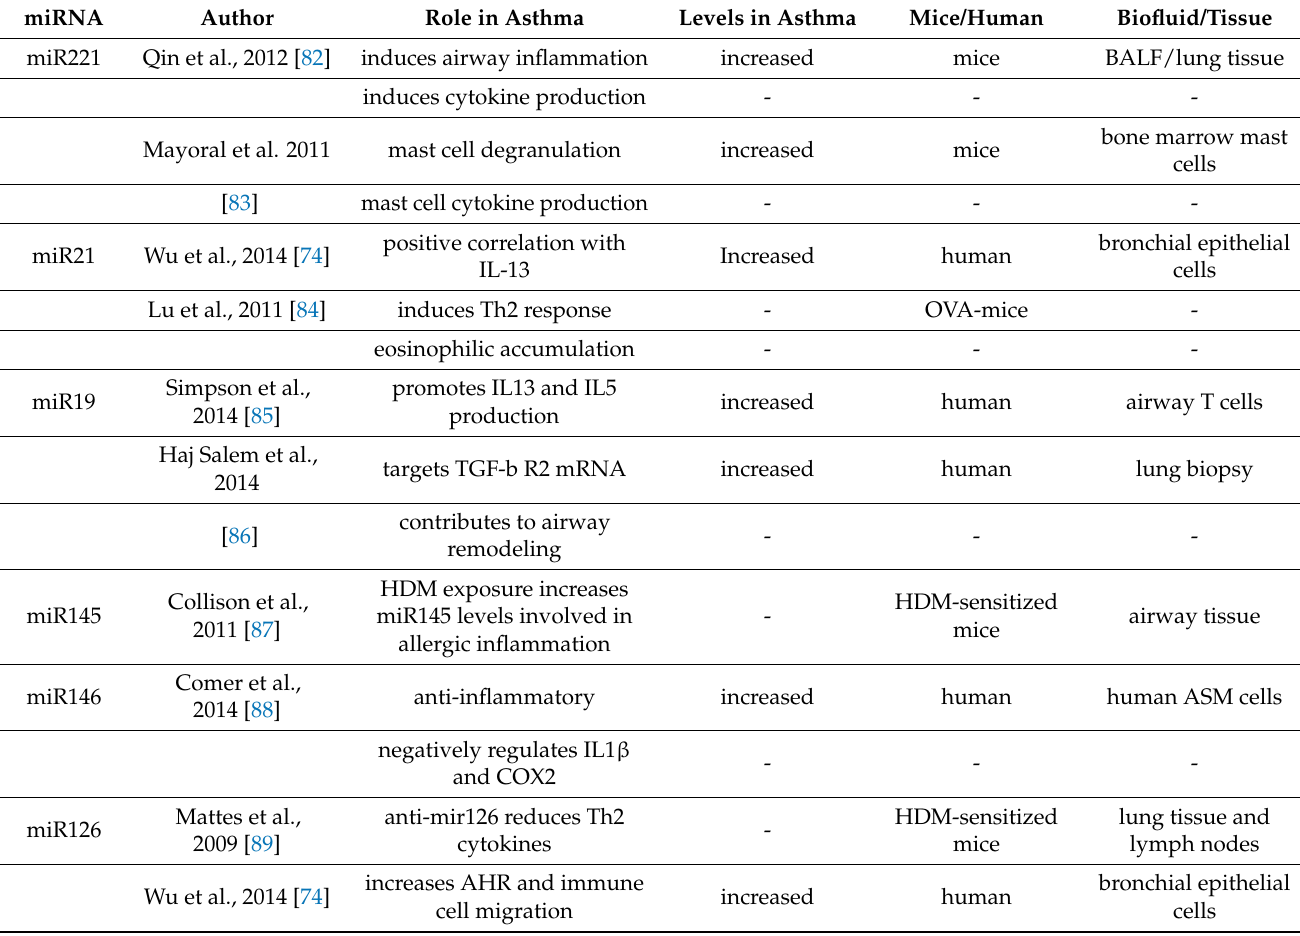
Table 2. Results of miR studies in association with asthma